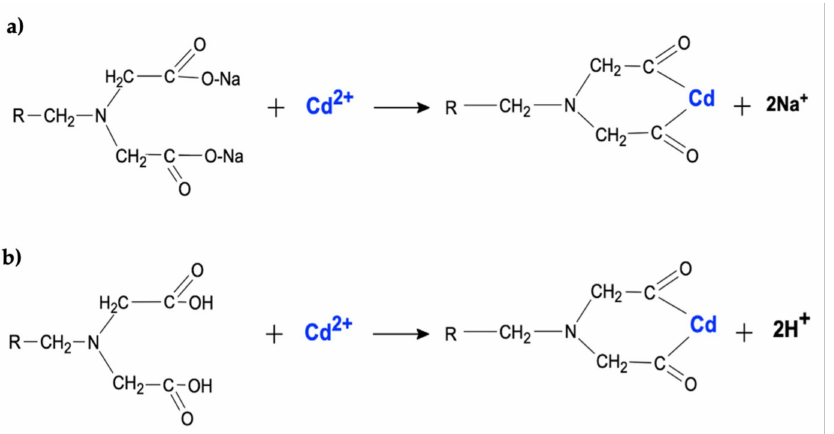
Figure 1. Iminodiacetic acid is the functional group of resin and the mechanism of chelating of cadmium by the ( a ) Na form and ( b ) H